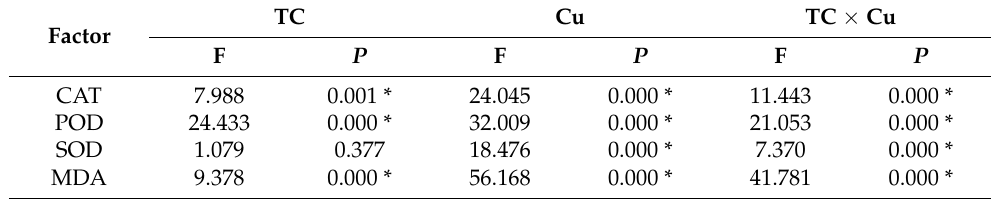
Table 3. Two-way ANOVA of TC and Cu on antioxidant enzyme activity and MDA in water spinach. Factor